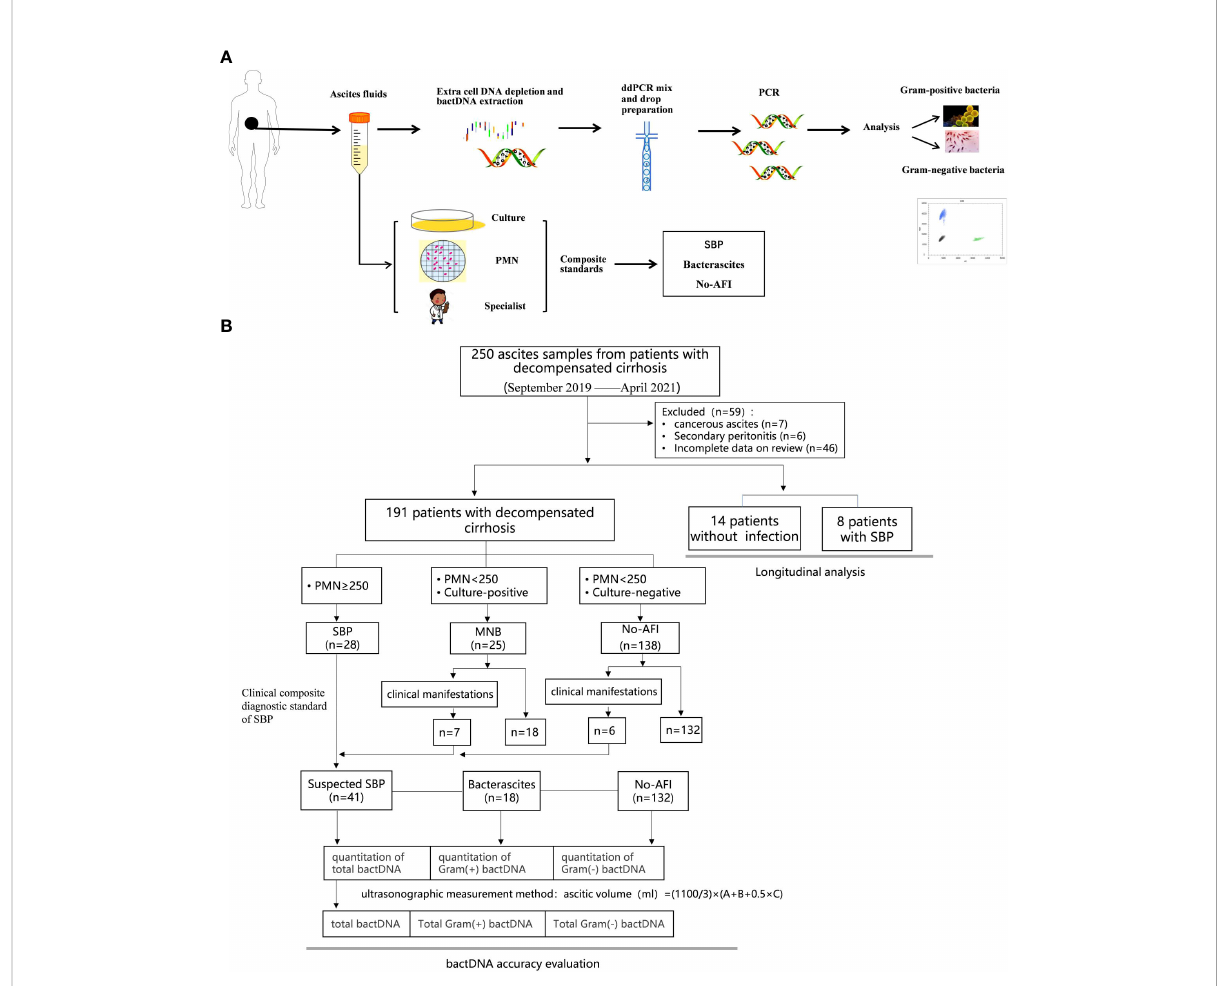
FIGURE 1 Study work fl ow and sample distribution. (A) Schematic of ddPCR ascites analysis work fl ow. A total of 1.5 – 2 h were needed for nucleic acid extraction and 2 h for the preparation, ampli fi cation, and analysis in ddPCR quantitation detection. (B) Overall fl ow of patients in the study showing patient recruitment and subsequent selection for bactDNA quantitation analysis. ddPCR, droplet digital PCR; PMN, polymorphonuclear; SBP, spontaneous bacterial peritonitis; MNB, monomicrobial non-neutrocytic bacterascites; AFI, ascites fl uid infection. Gram(+), Gram-positive; Gram( − ),